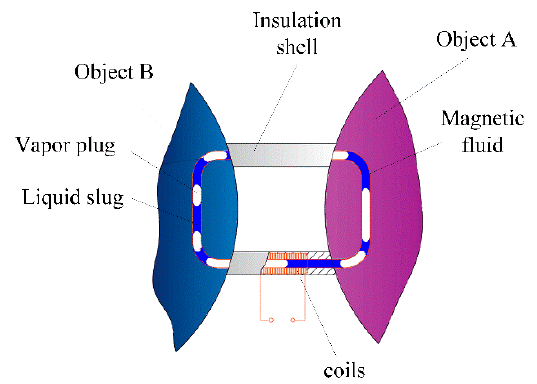
Figure 2. Schematic of a sensor used for monitoring temperature difference.